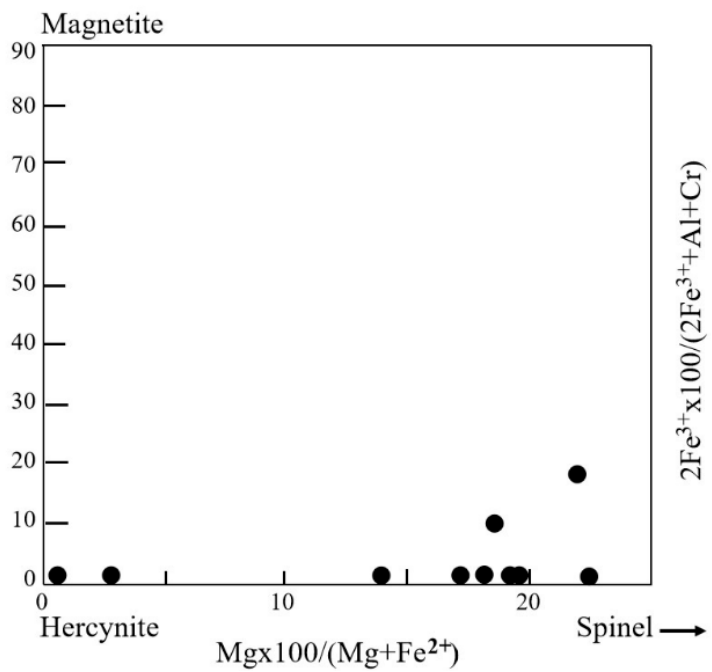
Figure 9. Compositional plots of hercynite spinel inclusions in sapphires from Southern Vietnam. This diagram was suggested by Haggerty [34].